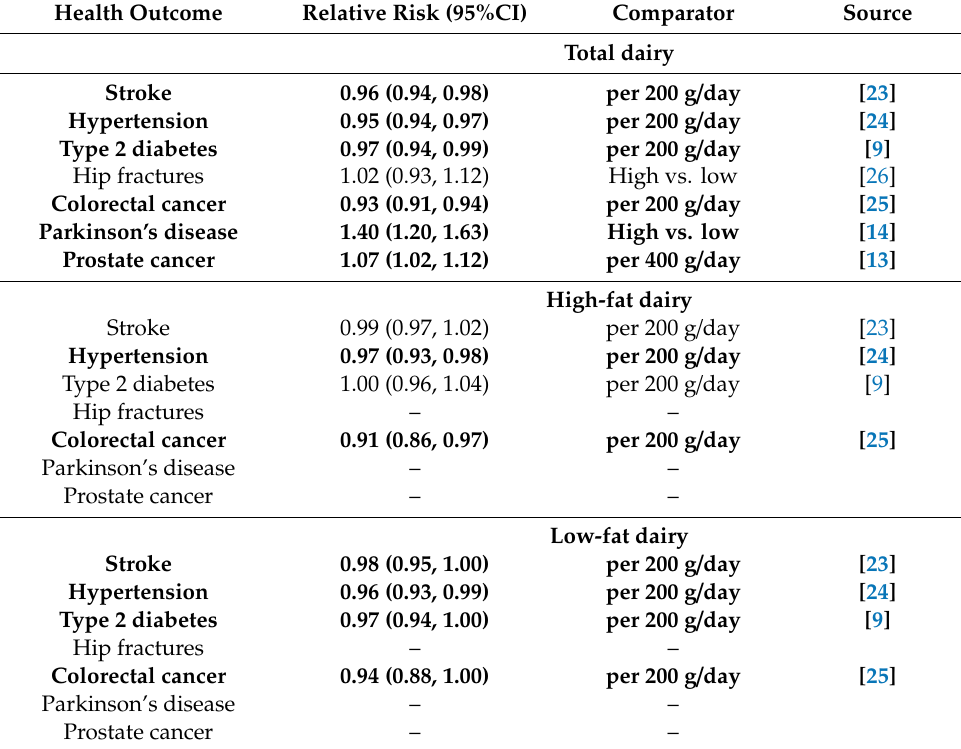
Table 2. Summary of published risk estimates for health outcomes associated with dairy